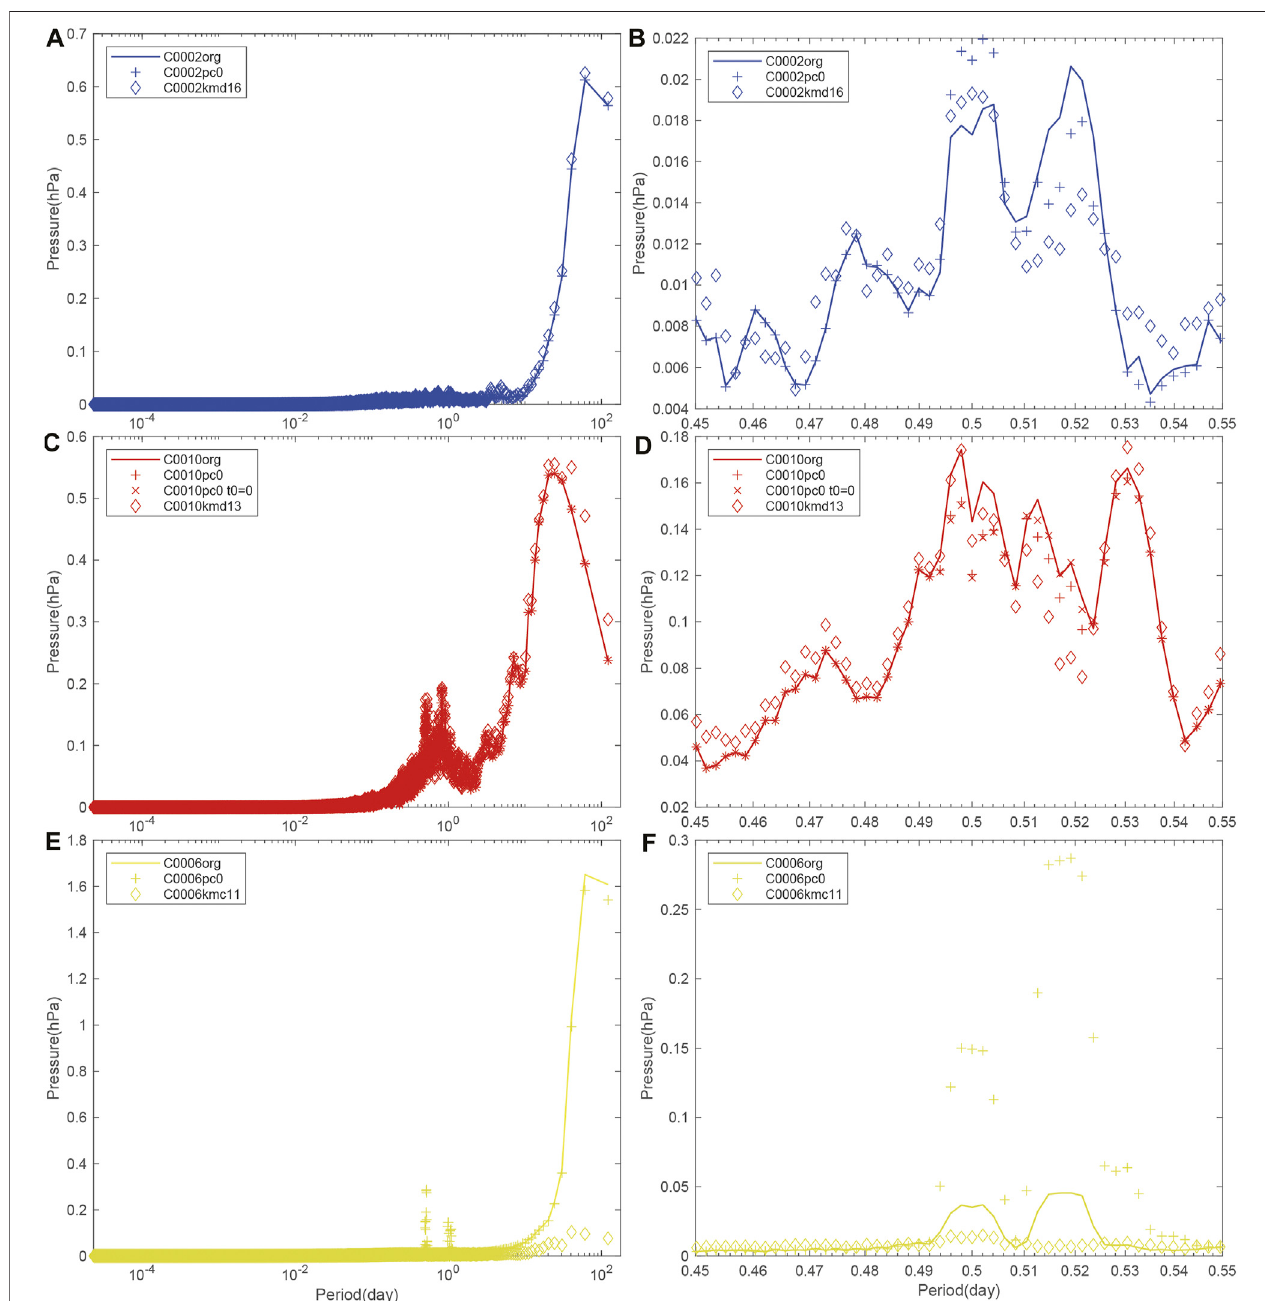
FIGURE 8 | (A,C,E) Amplitude spectrum of pore pressure at Pc1_Pp at each borehole, (B,D,F) focusing on M2 and S2 tides, compared with Figure 2 (org). For C0010, Pc0 with t 0 (cid:2) 0 is additionally